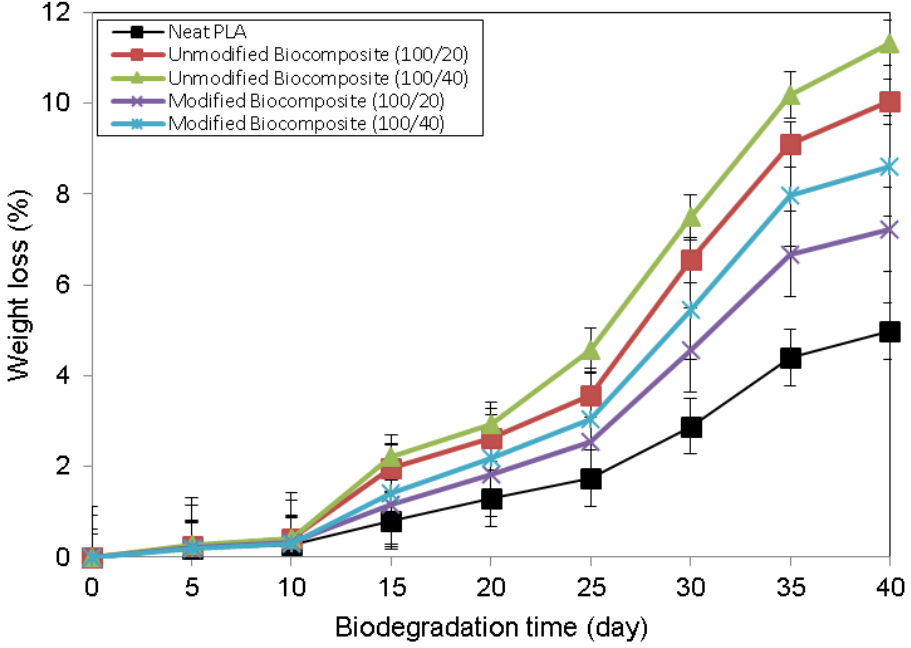
Figure 9. Percentage of weight loss of neat PLA, and unmodified and modified PLA/chitosan biocomposites, as a function biodegradation time.